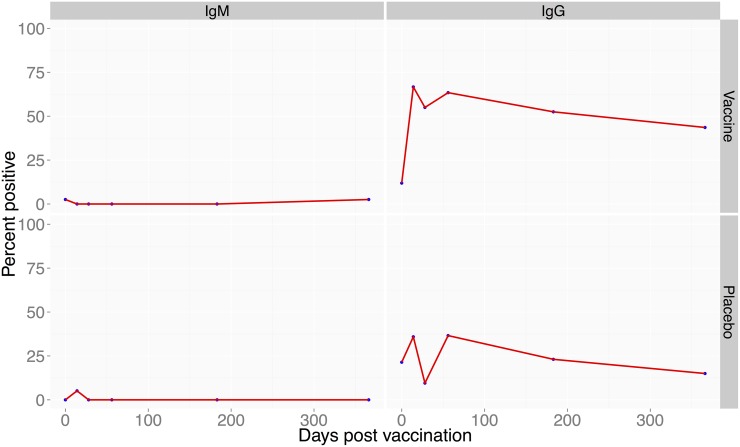
Proportion of cattle positive for anti-RVF antibodies following vaccination with RVF Clone 13 vaccine.Left panel (bottom) shows proportion of cattle with IgG antibodies following vaccination 14 to 366 days post-vaccination. The right panel (bottom) shows proportion of cattle that produced anti-RVF IgM antibodies over the 1 year period. The top panel on the left and right are the placebo-treated animals.